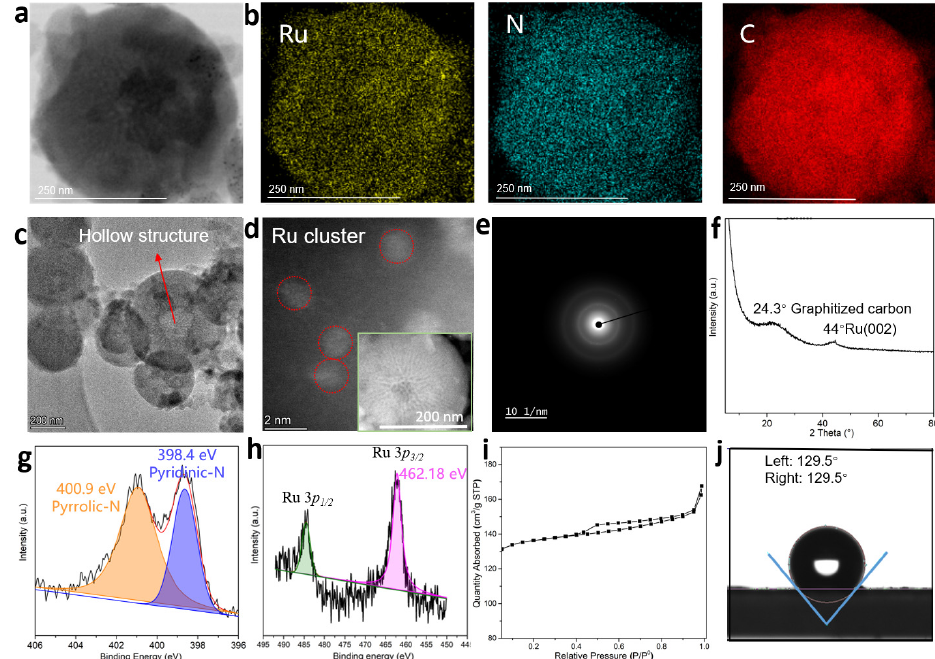
Figure 2. Characterization of Ru@N-CS catalyst. ( a ), HRTEM image of Ru@N-CS. ( b ), Atomic- resolution EDX elemental mapping of Ru@N-CS. ( c ), STEM image of Ru@N-CS. ( d ), A